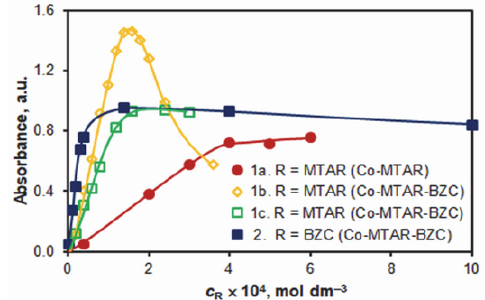
Figure 4. Effect of MTAR (1a,b,c) and BZC (2) concentration. (1a)